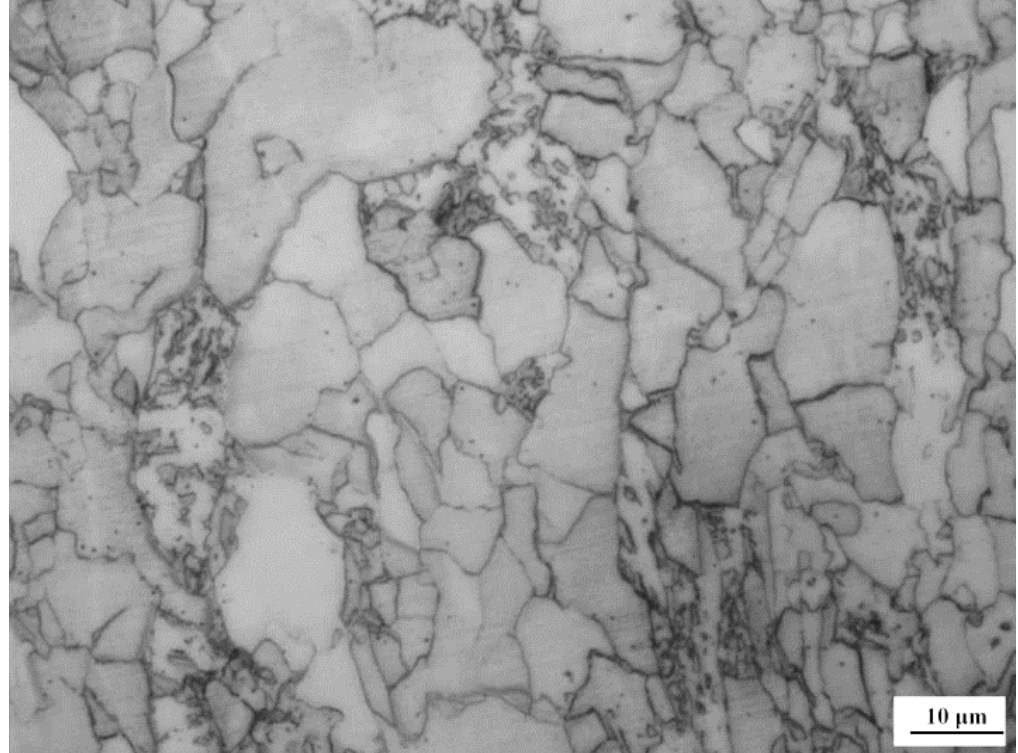
Figure 1. Optical microstructure of the hot-rolled experimental steel.